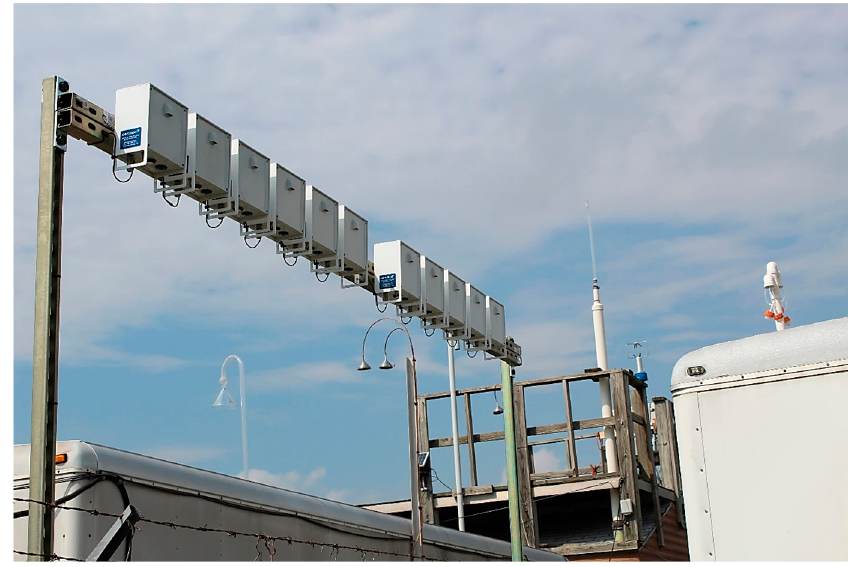
Figure 1. AQY1 Units Installed at the Reference Site at Hinton, Dallas, Source: Own Photo.